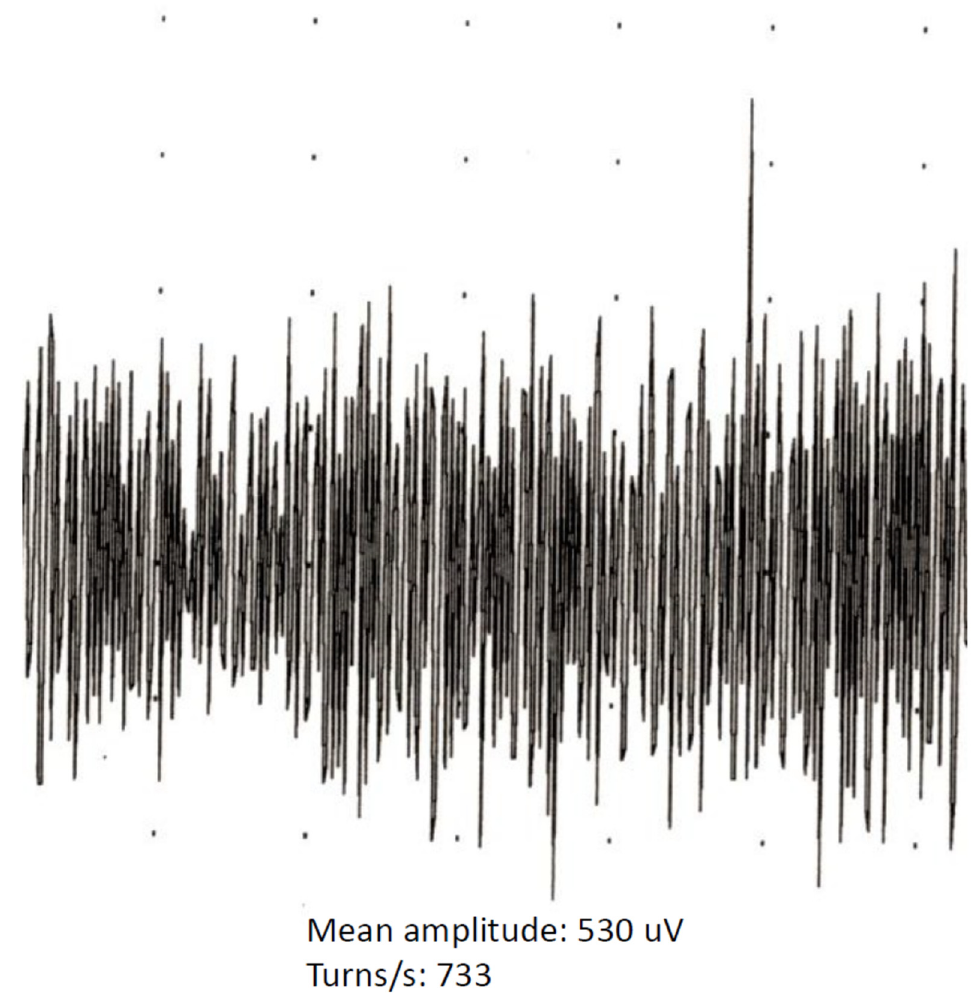
Figure 2. Electromyography of the facial nerve with turns amplitude